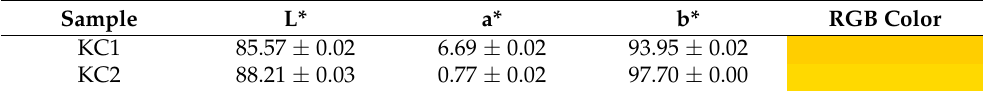
Table 2. L*, a* and b* color parameters of the produced